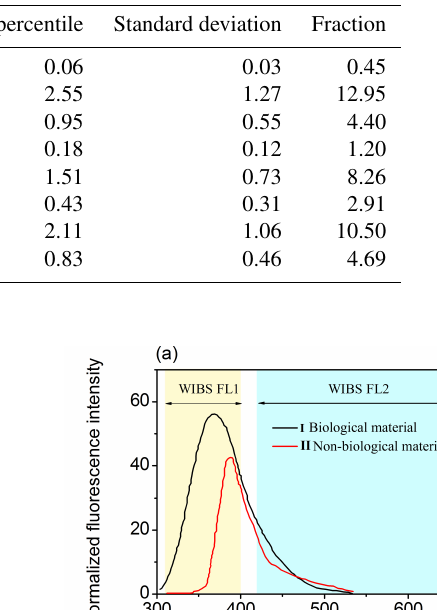
Table 3. Integrated number concentrations (cm − 3 ) of each FAPs and fractions (%) of FAPs number concentrations to the total particle number concentrations. Type AC is not listed.